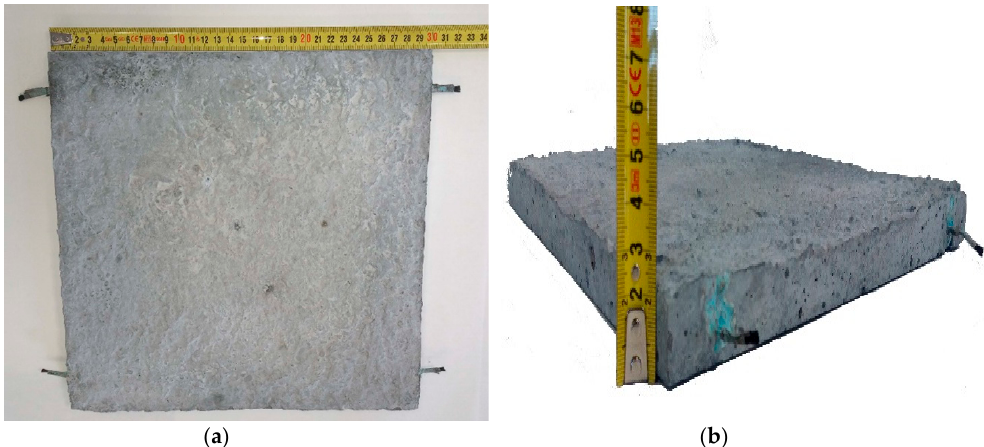
Figure 2. Specimen appearance after fabrication: ( a ) top view; ( b ) thickness.